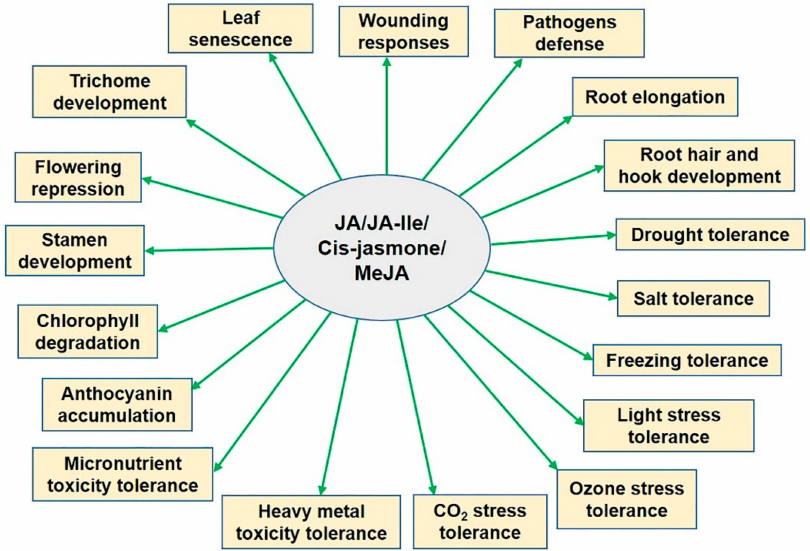
Figure 1. Various plant processes modulated by jasmonic acid and its isoleucine conjugate in response to abiotic stresses. JA, jasmonic acid; JA-Ile, jasmonyl isoleucine; MeJA, methyl